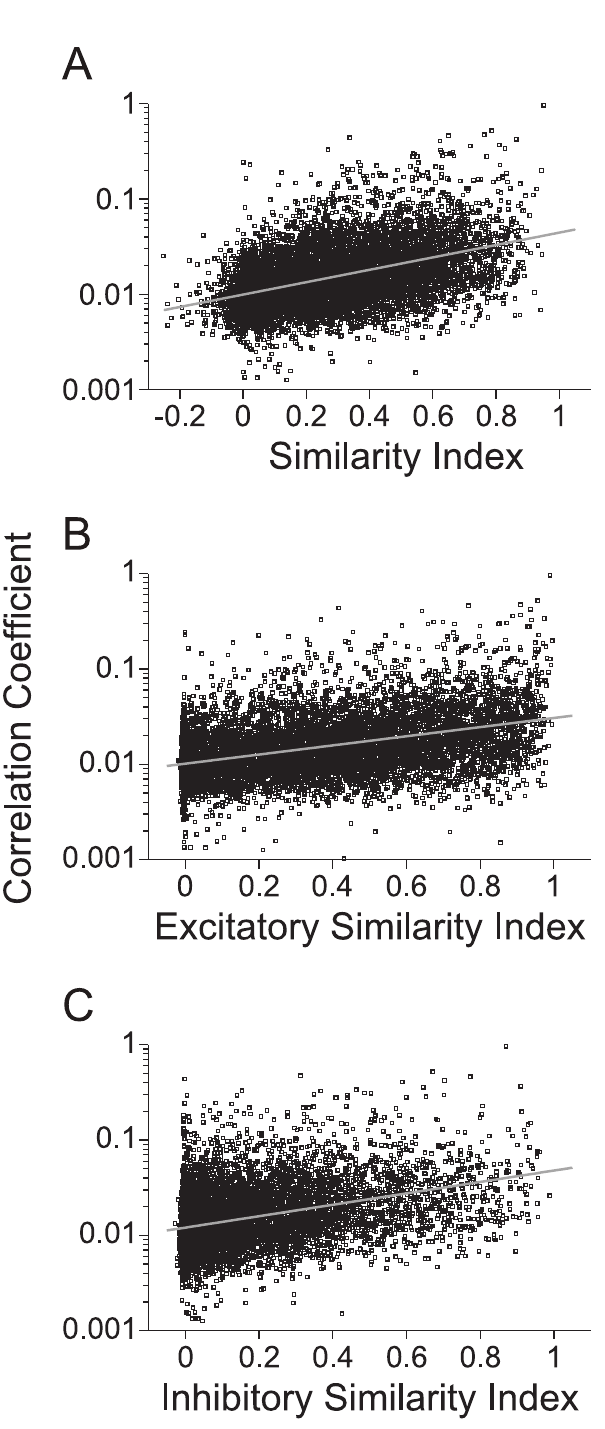
Figure 10. Connection strength versus STRF similarity. Correla- tion coefficient values as a function of (A) Full STRF similarity between functionally connected neurons (r=0.464, p , 0.01, t-test). (B) Similarity between only the excitatory STRF subfields (r=0.433, p , 0.01, t-test). (C) Only the inhibitory STRF subfields (r=0.379, p , 0.01, t-test). (N=8364).